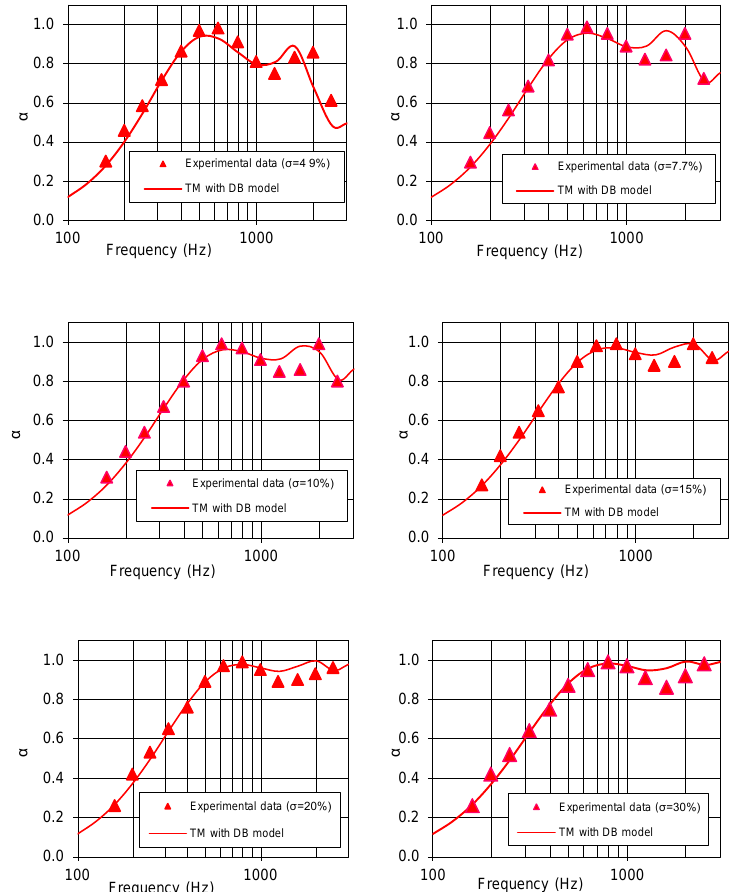
Figure 13: Experimental and predicted normalincidence sound absorption coeflcient comparison (no air gap)